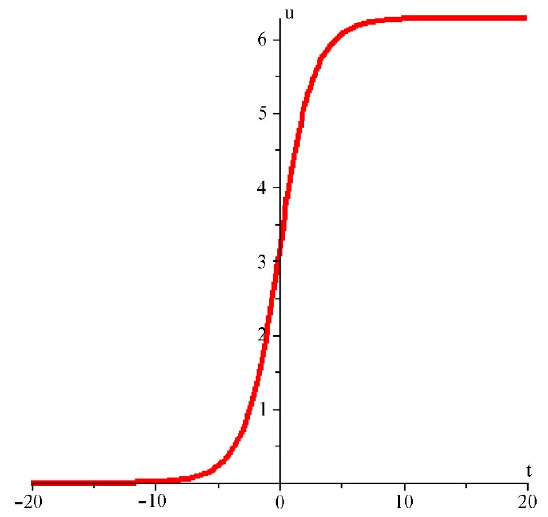
Figure 11. Displacement u at V = 0.5, shown as a function of time (anti-kink). The displacement as a function of the coordinate and time at V = 0.5, demonstrating plastic deformation, is shown in Figure 12.